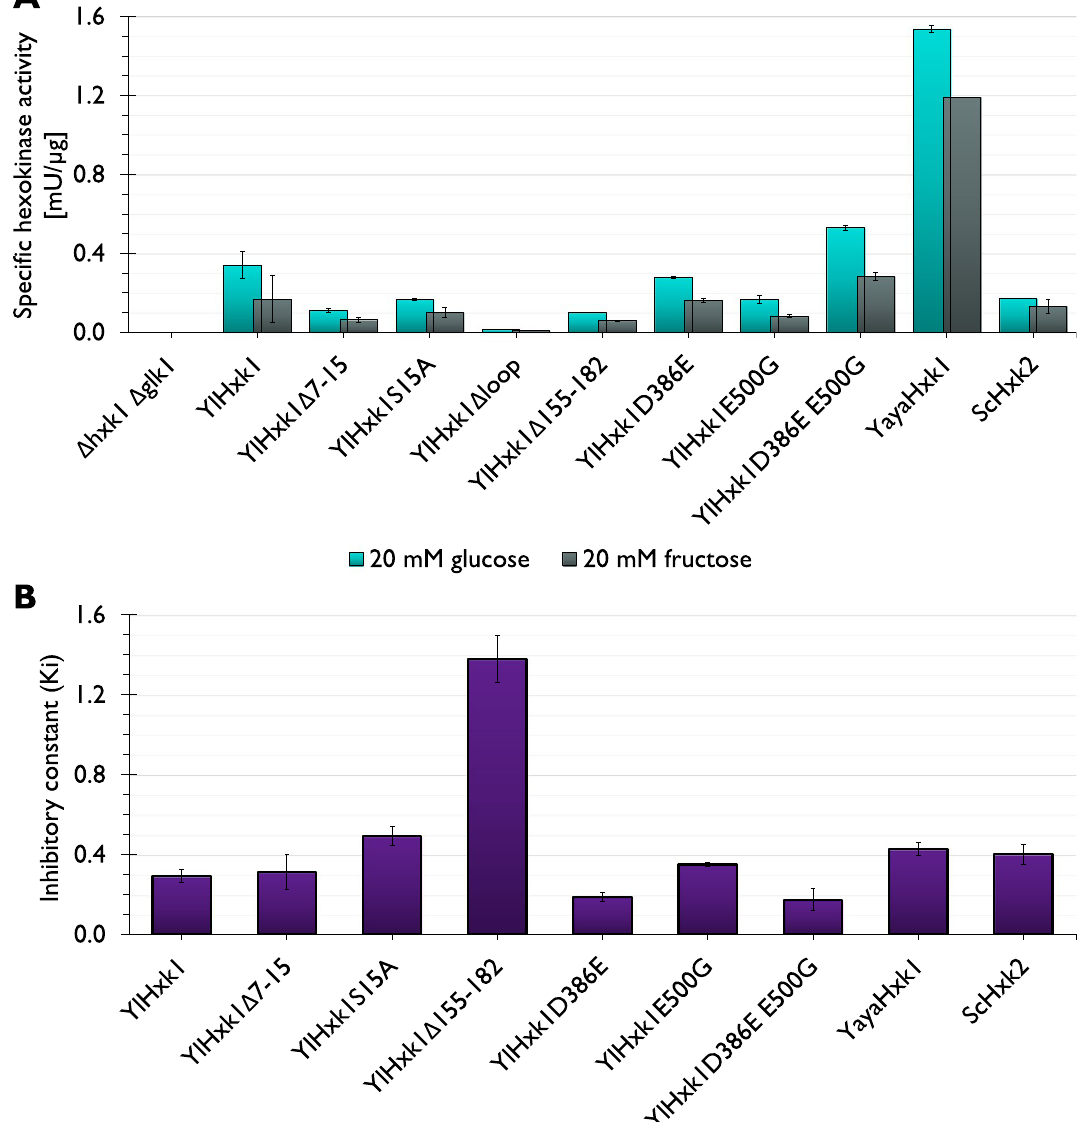
Figure 5. Kinetic parameters of the analyzed hexokinases. ( A ) Specific hexokinase activities; ( B ) inhibition constant values, assayed with 20 mM glucose.